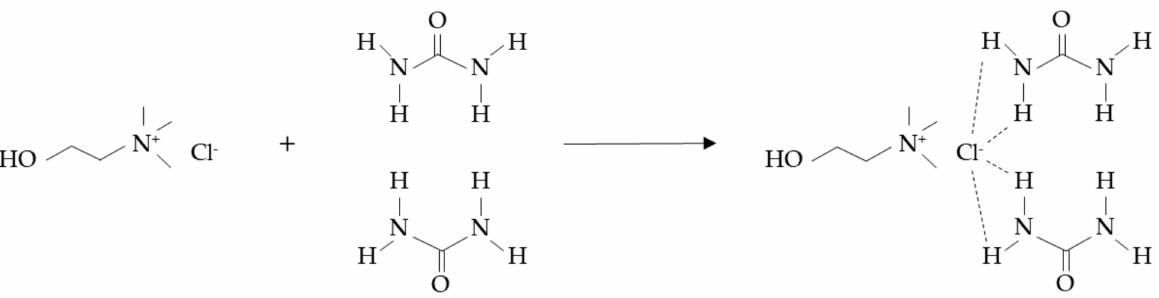
Figure 2. Hydrogen bonding in a ChCl:urea DES.